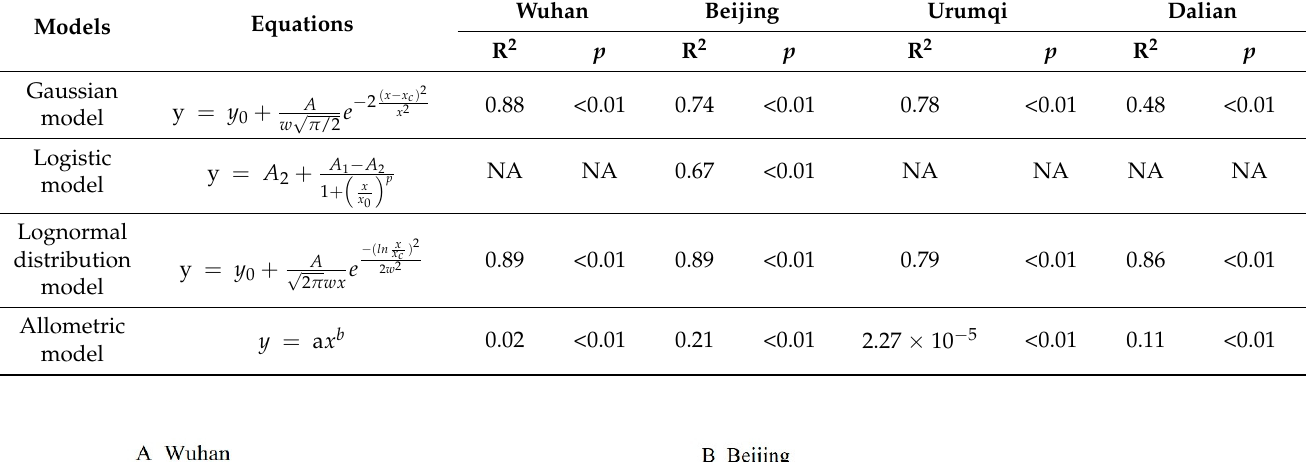
Table 2. The fitting models of COVID-19 infected cases during the period of community-based epidemic prevention and control. NA indicates no appropriate model to fit the change of COVID-19 infected cases because R 2 is less than 0.